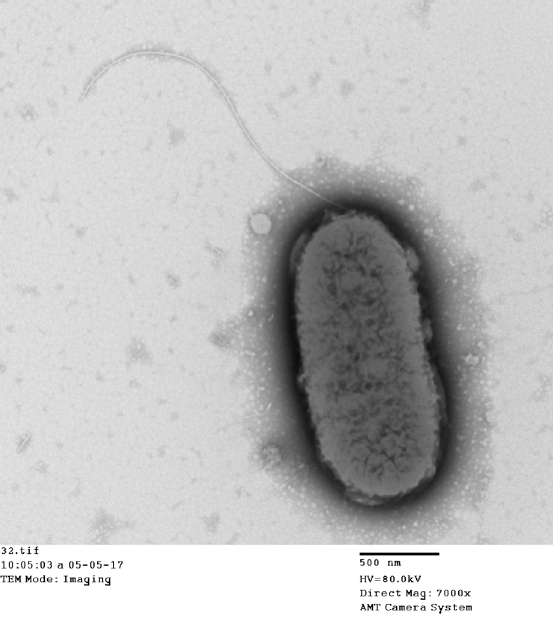
Figure 3. Electron micrograph of GJL1, bar = 0.5 μ m.